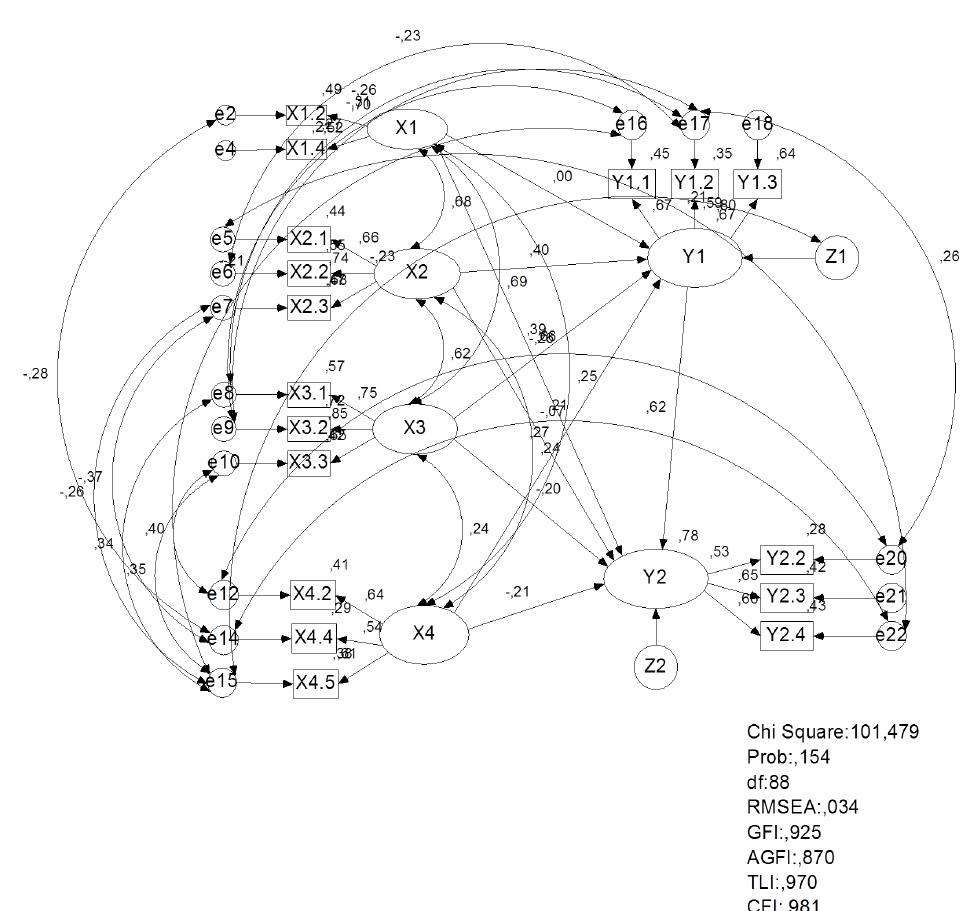
Figure 3. Results of final-stage SEM